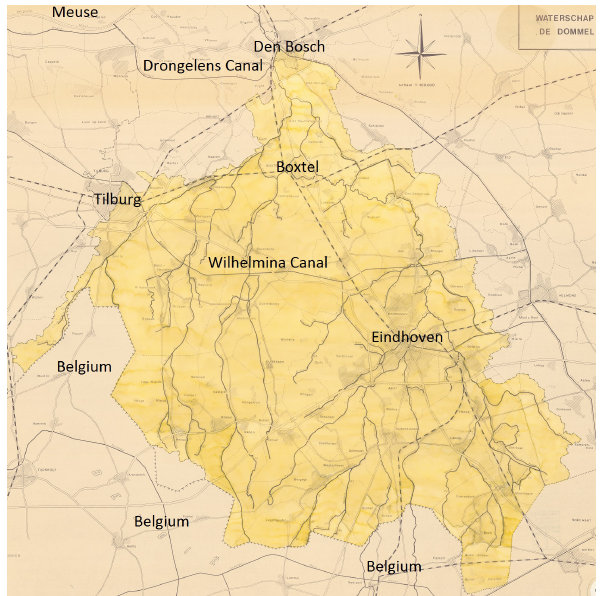
Figure 1. Map of the Dutch part of the Dommel Basin in 1971 (Website Brabant Historisch Informatie Centrum, www.bhic.nl; ge- ographical names